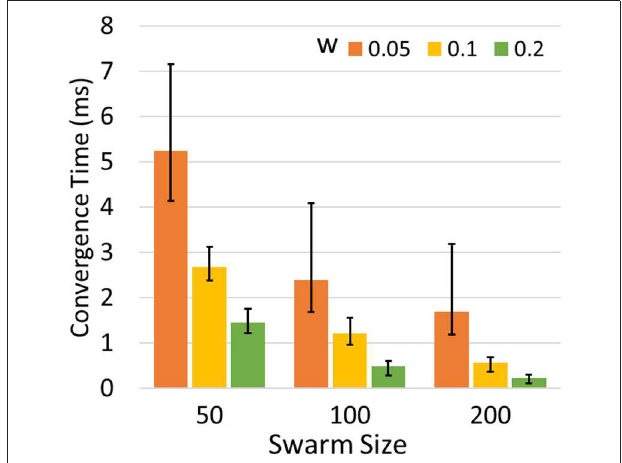
FIGURE 7 | Average convergence time to optimize 2-D Schwefel’s function in different m and w. The error bars indicate the maximum and minimum time cost.